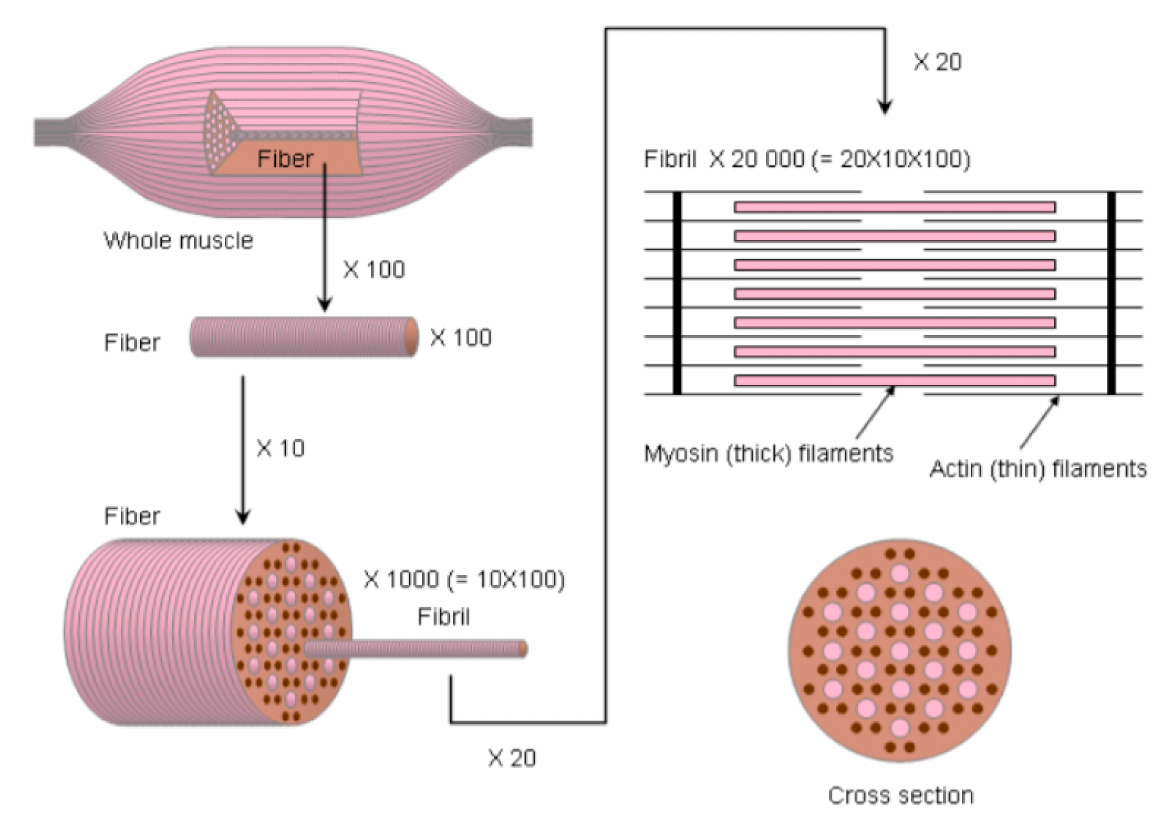
Figure 5. This is a view of a muscle fiber under various orders of magnification